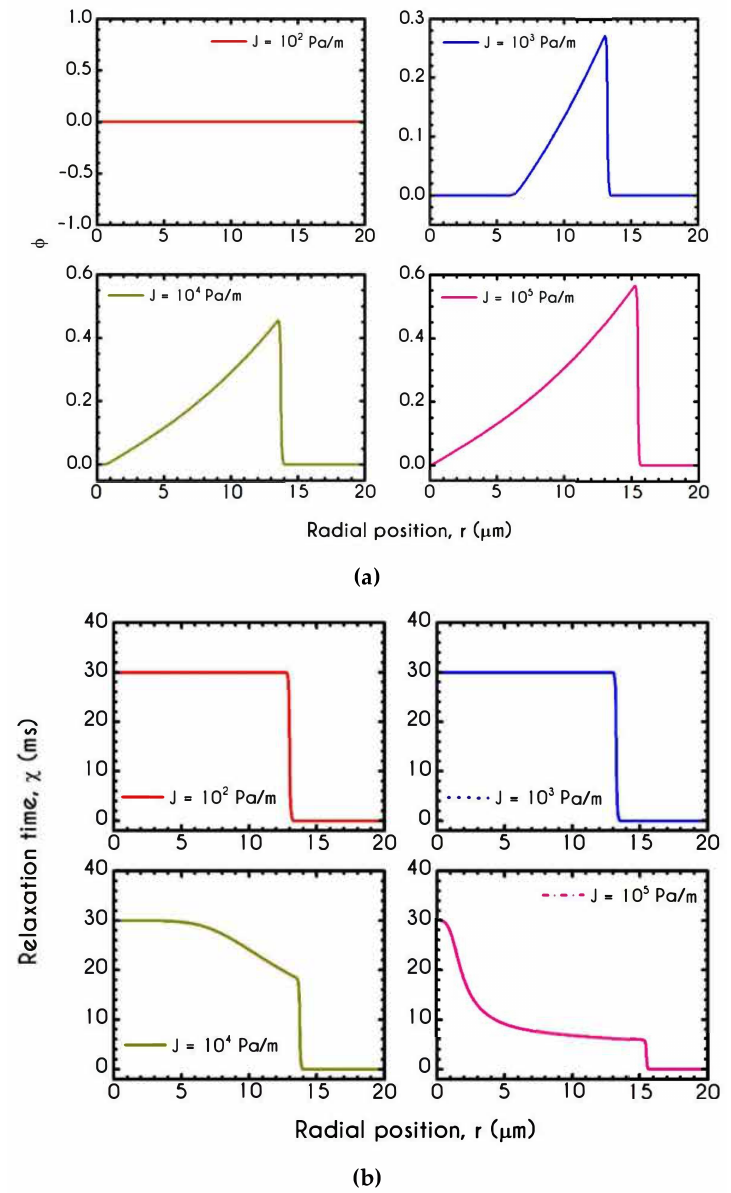
Figure 19. ( a ) Parameter ϕ along the radial position and ( b ) Relaxation time χ for different pressure gradients J equal to 10 2 Pa/m, 10 3 Pa/m, 10 4 Pa/m, and 10 5 Pa/m for R = 20 µ m and H c =